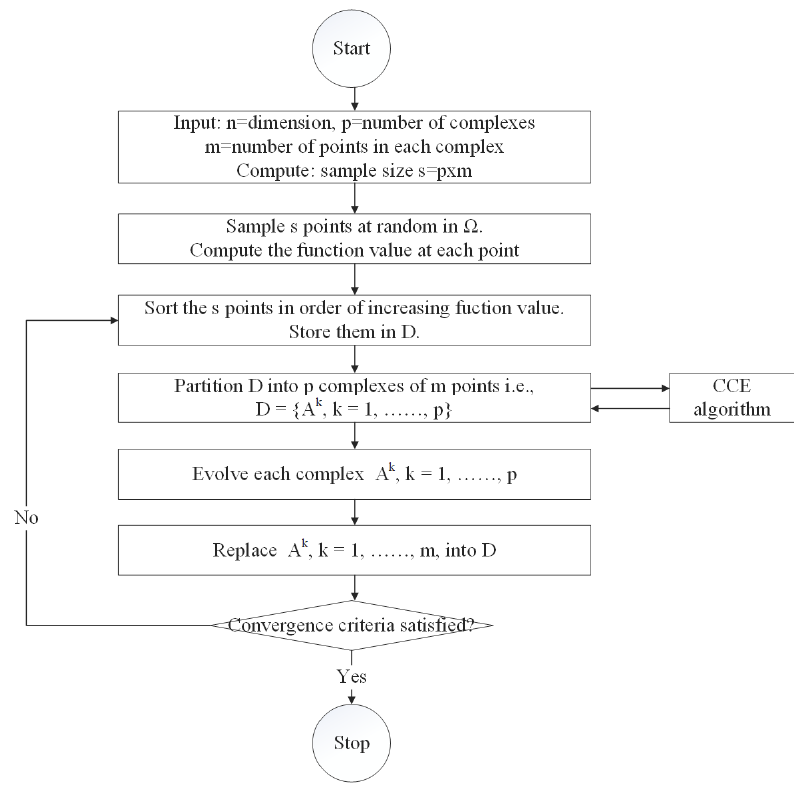
Figure 4. Flow of the shuffled complex evolution (SCE-UA) method.